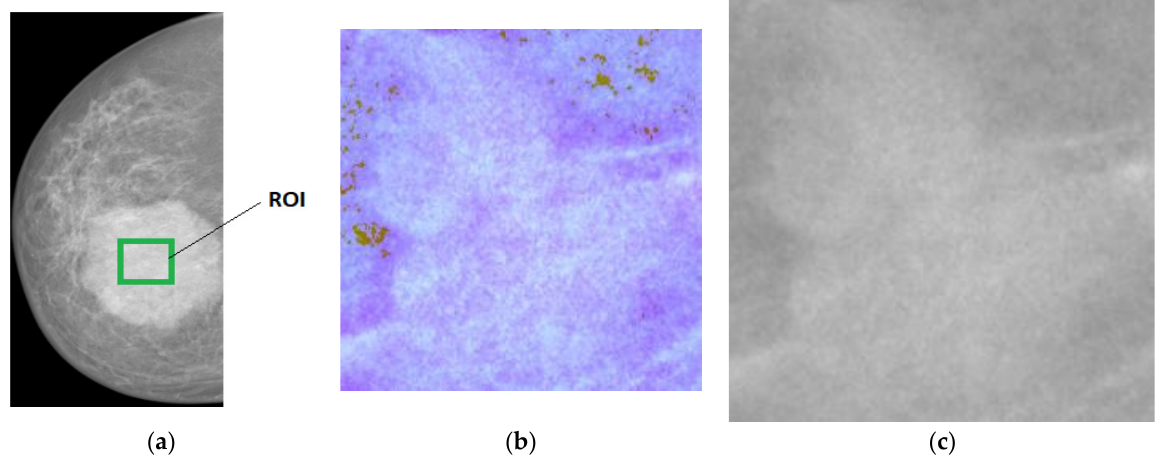
Figure 3. Example of data preparation phase for generating the pseudo-colored image based on the original grayscale X-ray mammogram. ( a ) Region of interest (ROI); ( b ) Pseudo-Colored image; ( c ) Grayscale image.